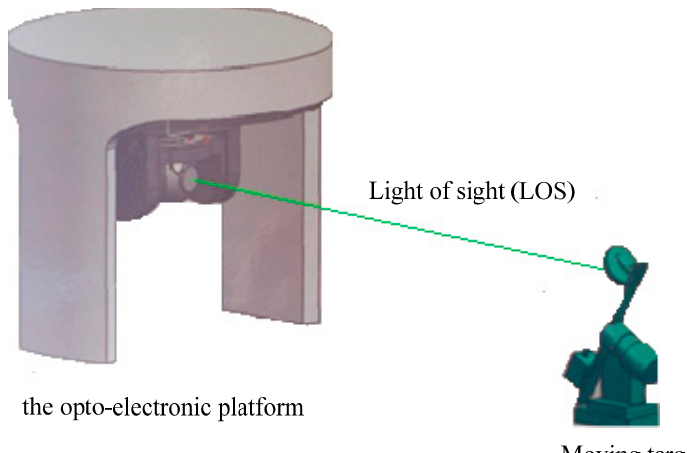
Figure 9. Schematic diagram of tracking experiment on the opto-electronic platform.